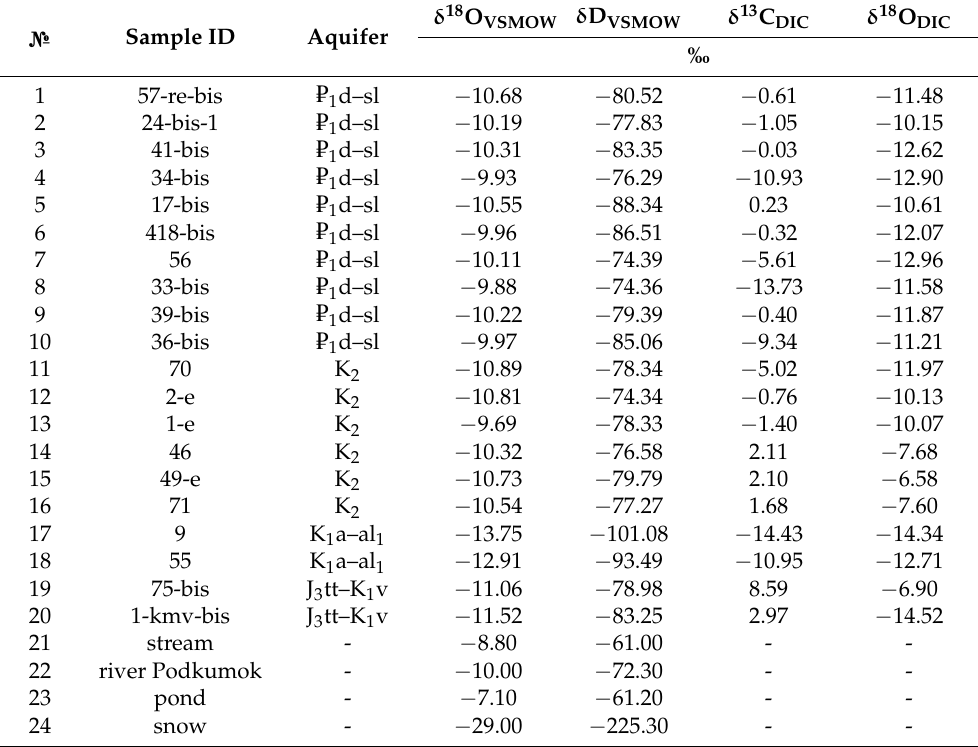
Table 1. Characteristics of the studied water